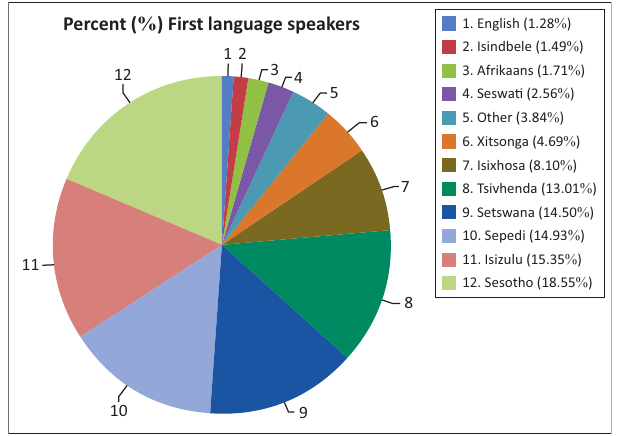
Figure 1 indicates the language profiles of the participants. English as their first language.